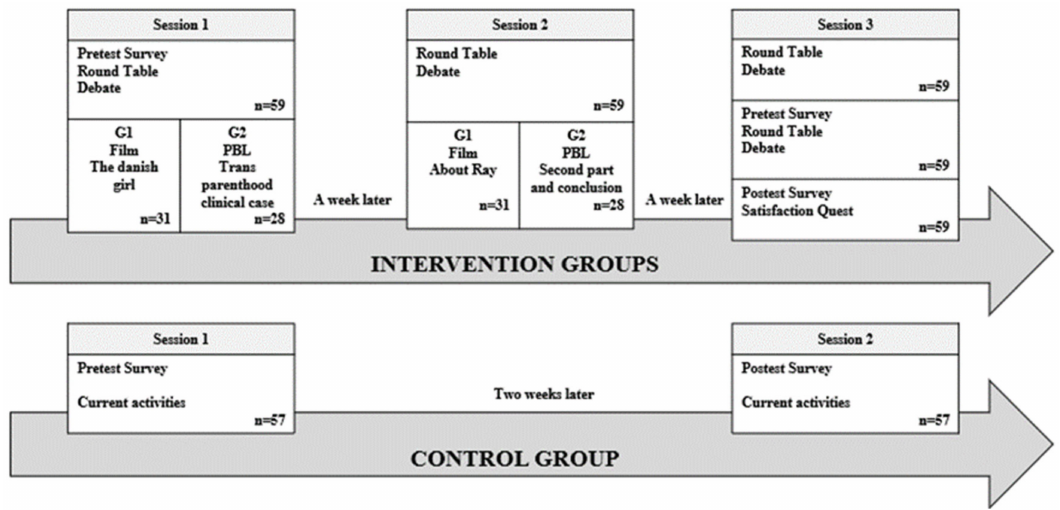
Figure 1. The flow chart of the formative program: TGSC&W